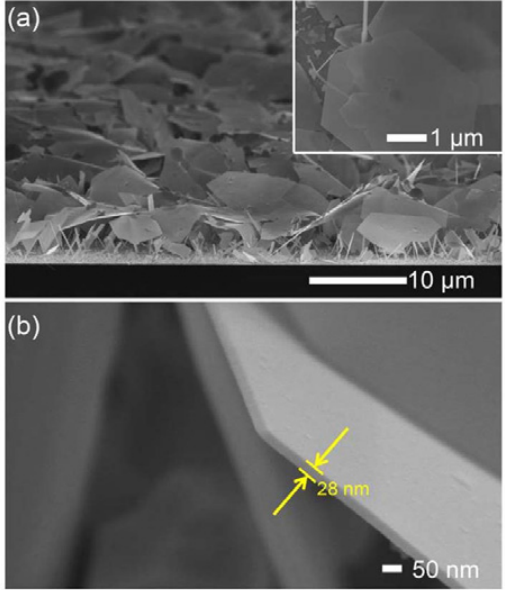
Fig. 4: Typical SEM images of Ag nanosheets. (a) Typical 13°-tilted SEM images of Ag nanosheets grown on a substrate and (b) a higher magnified SEM image of a Ag nanosheet. (The inset indicates a higher magnified top-view SEM image). Reproduced with permission from ref. 34, copyright 2013, Springer.